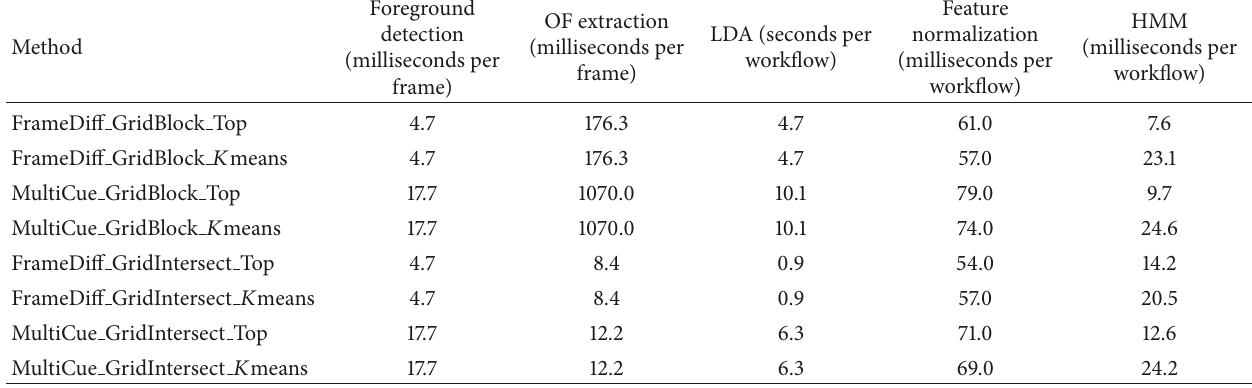
Table 10: Average calculation time of each step in all methods for a test surgical workflow (12.8 minutes of length).